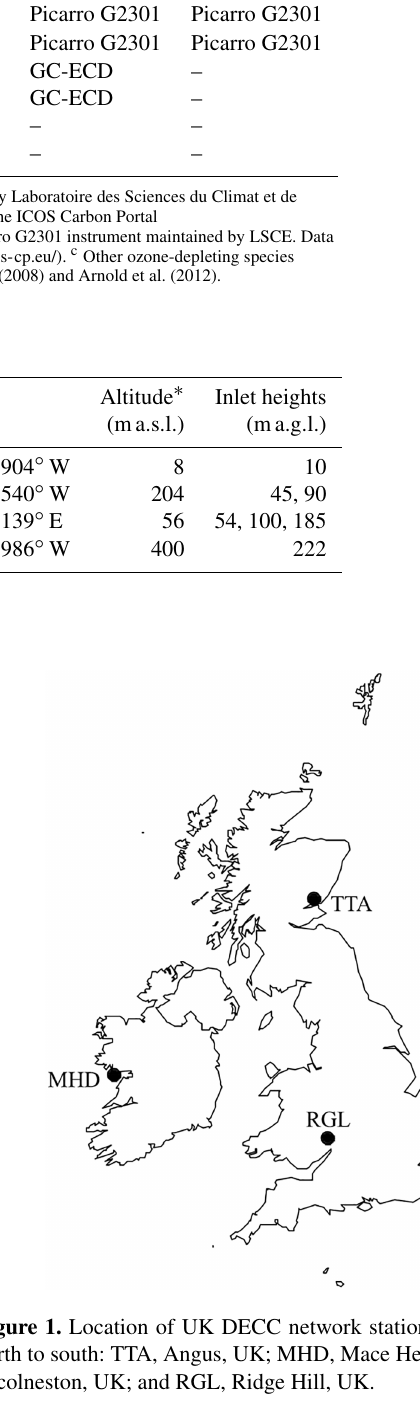
Table 1. Greenhouse gas and ozone-depleting substance species and instrumentation at each UK DECC site. Species Sites Mace Head